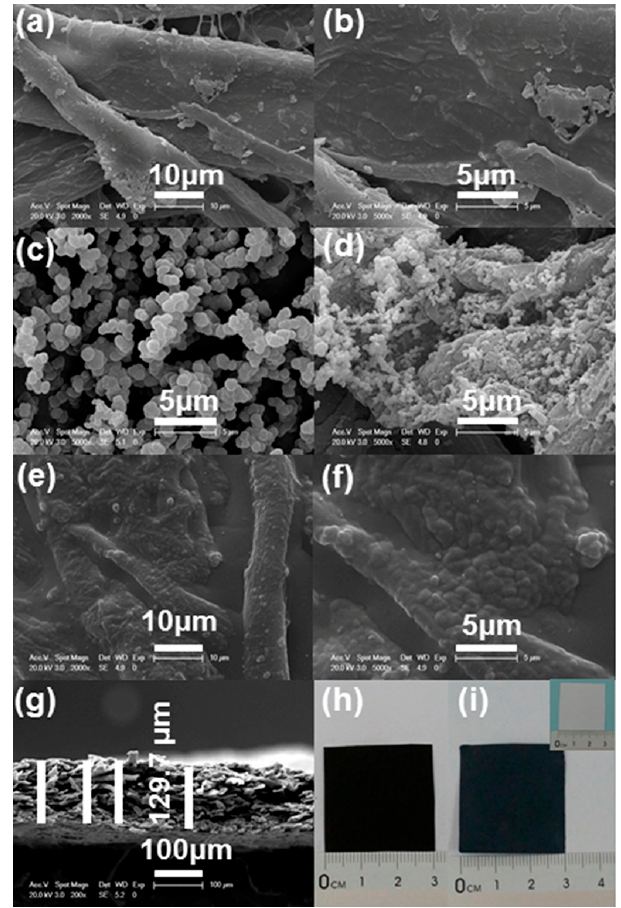
Figure 2. ( a , b ) SEM images of paper; ( c ) PPy particles; ( d ) PPy/paper composite film; ( e , f